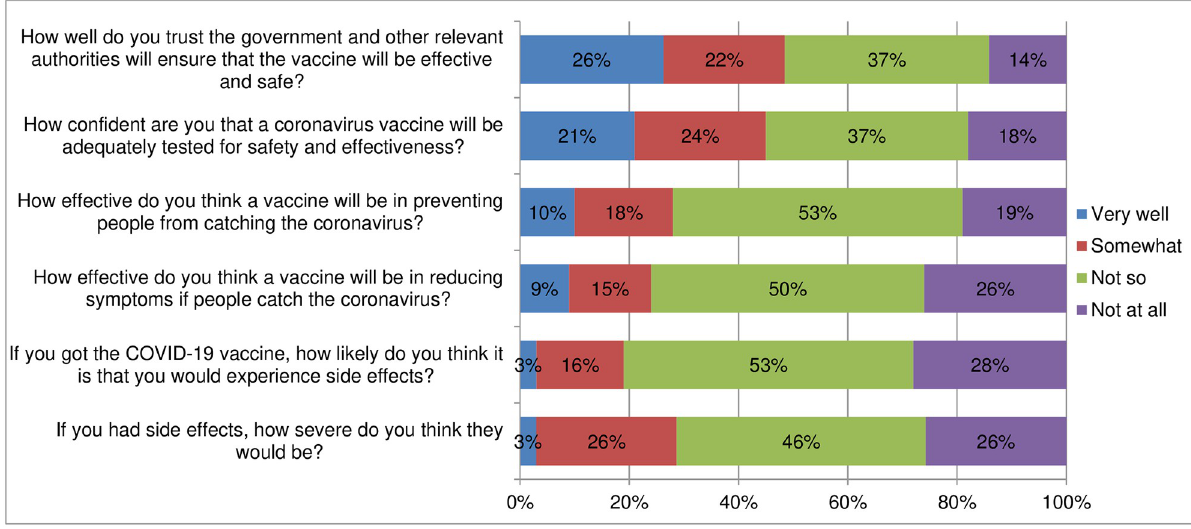
Fig 2. Perceived vaccine effectiveness and safety of the COVID-19